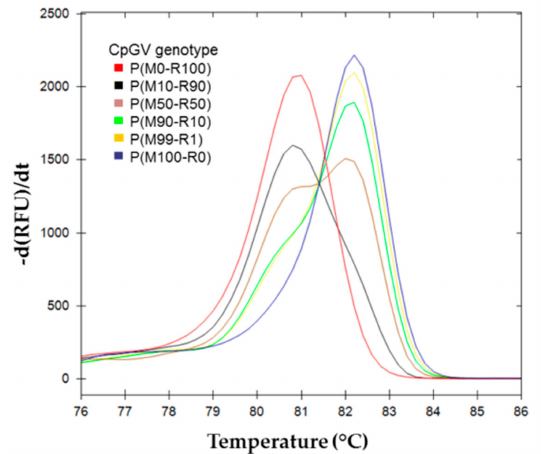
Figure 6. Melting curves analysis of pe38 amplicons from CpGV OBs extracted from infected larvae. First derivative of RFU (relative fluorescence unit) upon temperature profile are represented for each OB production analyzed. ( ) P(M0-R100); ( ) P(M10-R90); ( ) P(M50-R50); ( ) P(M90-R10); ( ) P(M99-R1); ( ) P(M100-R0).